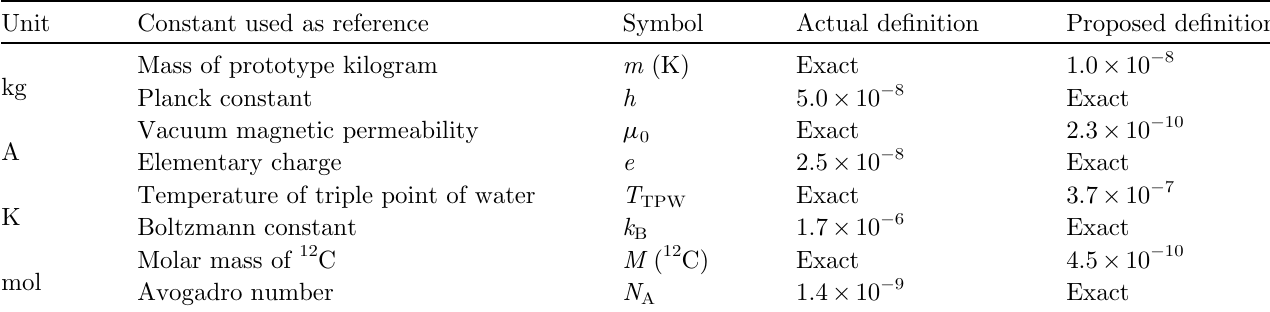
Table 2. Impact of new de fi nitions of the SI base